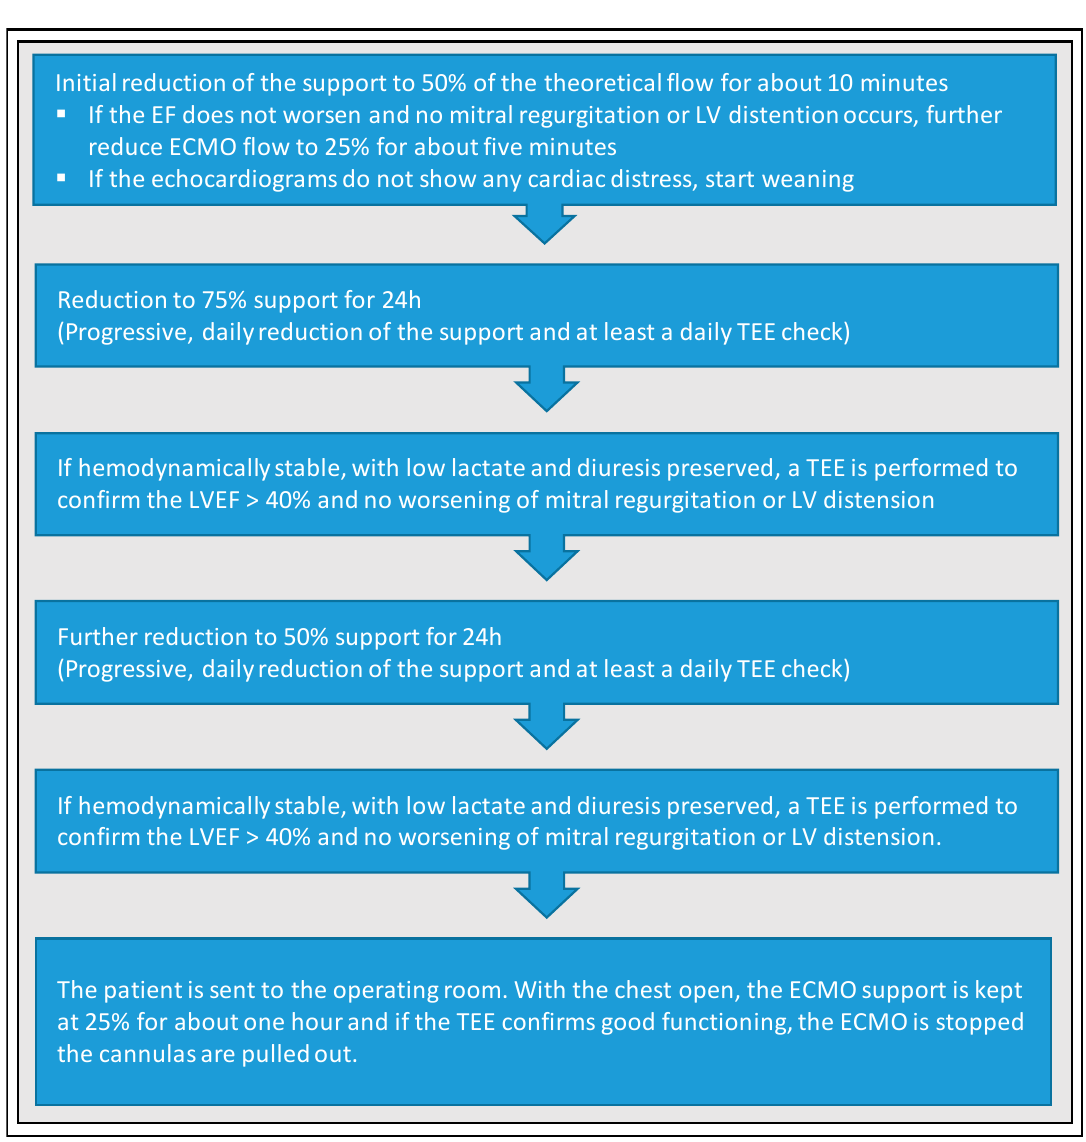
Figure 6. Standardized protocol for weaning from VA-ECMO for graft failure after heart transplantation according to Santise et al. [53]. TEE, transoesophageal echocardiography; LVEF, left ventricular ejection fraction; LV, left ventricle.